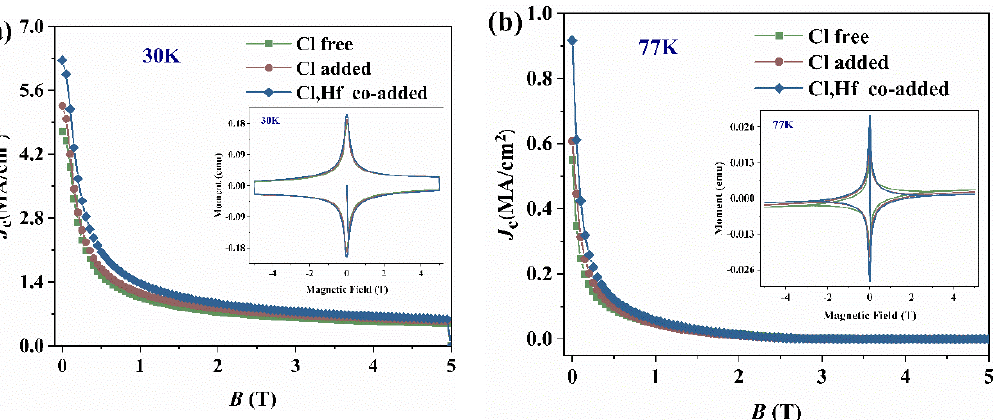
Figure 5. Field dependence of critical current density at 30 K and 77 K for Cl-free, Cl-added and (Cl, Hf) co-added YBCO films. ( a ) 30 K. ( b ) 77 K.